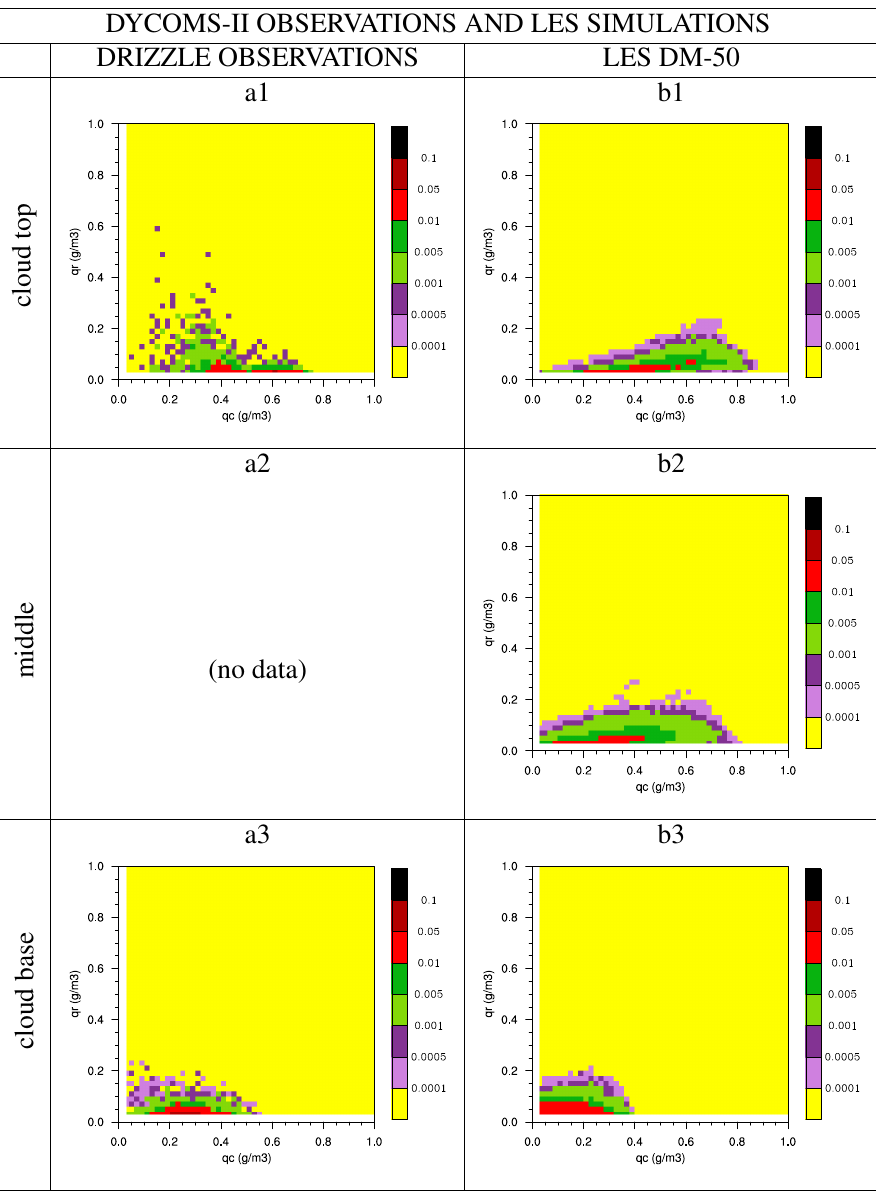
and q for cloud top, middle part and cloud base using c r